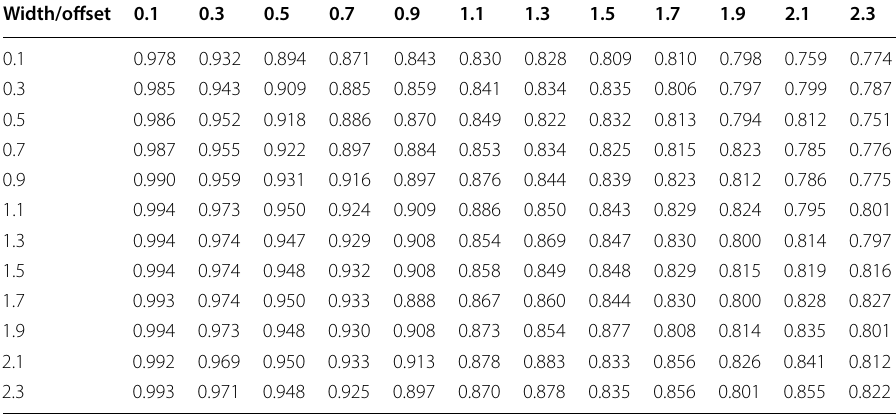
Table 1 Average AUC varying width and offset Width/offset